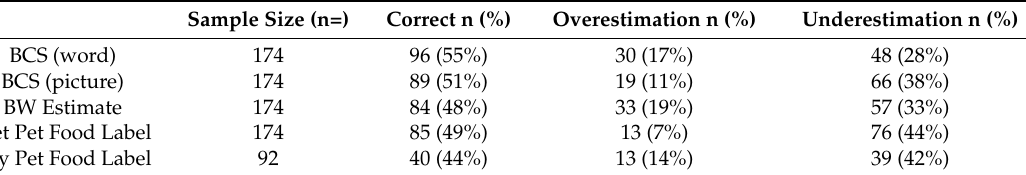
Table 2. The number and percentage of owners who correctly assessed, overestimated, and underestimated the body condition score (BCS) by word description and picture, bodyweight (BW) of their dog, and amount to feed following interpretation of wet and dry pet food labels.